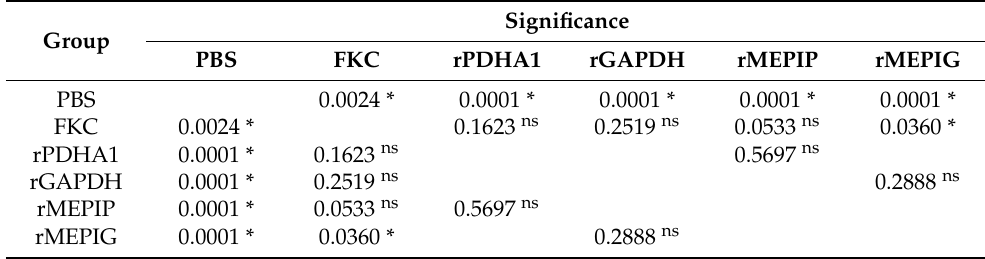
Figure 8. Cumulative mortality of flounder in FKC, rGAPDH, rPDHA1, rMEPIP, rMEPIG and PBS vaccination groups after challenge with S. iniae . Table 2. The results of the Log Rank method.